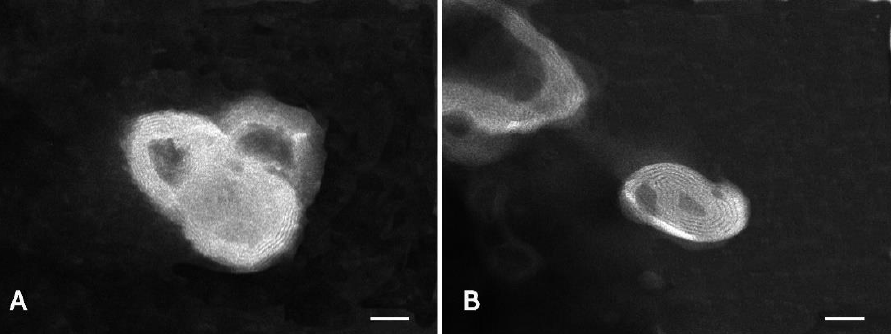
Figure 7. Transmission electron microscopy (TEM) images of empty liposomes ( A ) and honokiol-loaded liposomes ( B ). Bars correspond to 50 nm. Table 3. The mean diameter (MD), polydispersity index (PI), and zeta potential (ZP) of empty and